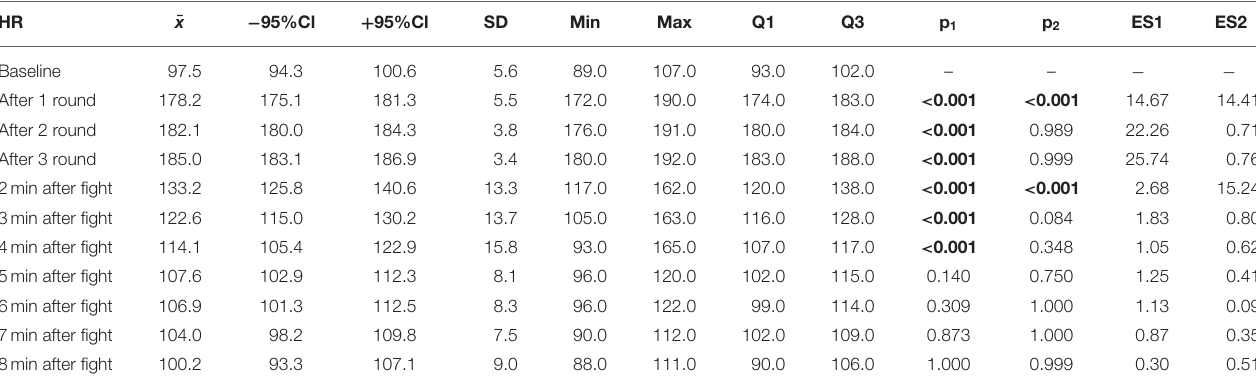
TABLE 3 | Heart rate in subsequent